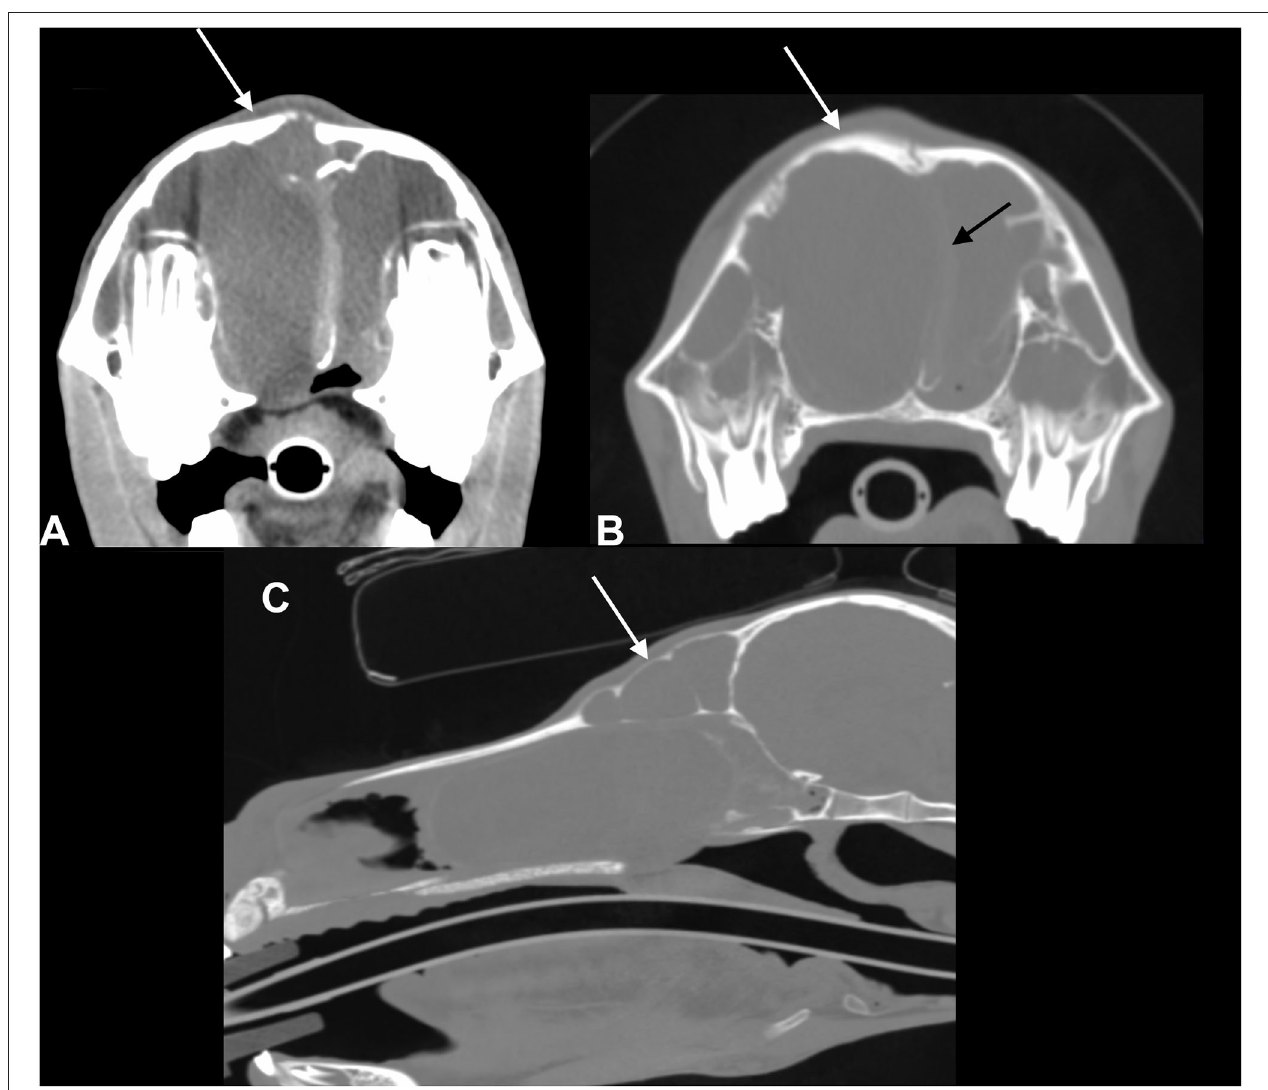
FIGURE 2 | Transverse CT images of a mini-Shetland pony with bilateral sinus disease (case 4) processed with soft tissue (A) and bone (B) filters (left in the image is right of the patient) and sagittal reformatted image processed with bone filters (C) . The white arrows indicate deformation of the frontal bone. The black arrow indicates the leftward shift of the nasal septum. Note the diffuse, homogeneous filling of the left and right sinus compartments with hypoattenuating fluid material; HU of the sinus content in this patient was